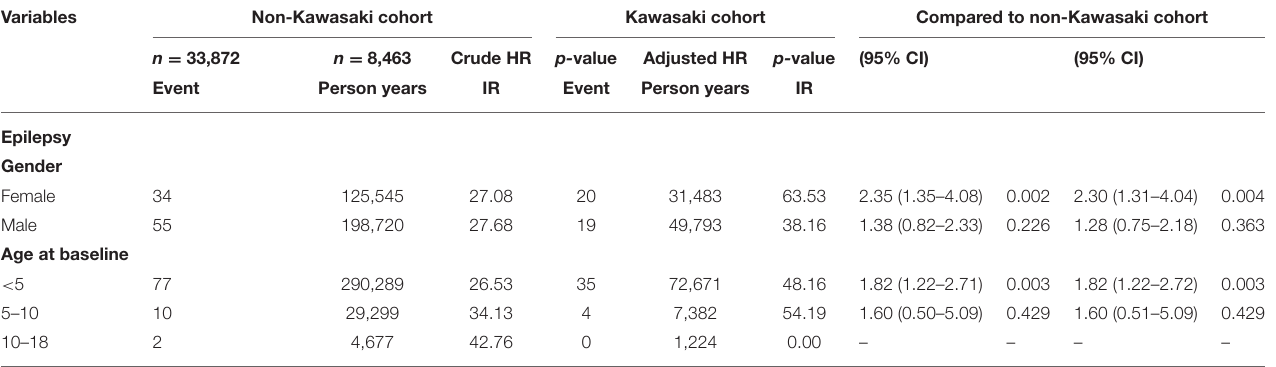
TABLE 3 | Incidence rates, hazard ratio and confidence intervals of epilepsy in different stratification. Variables